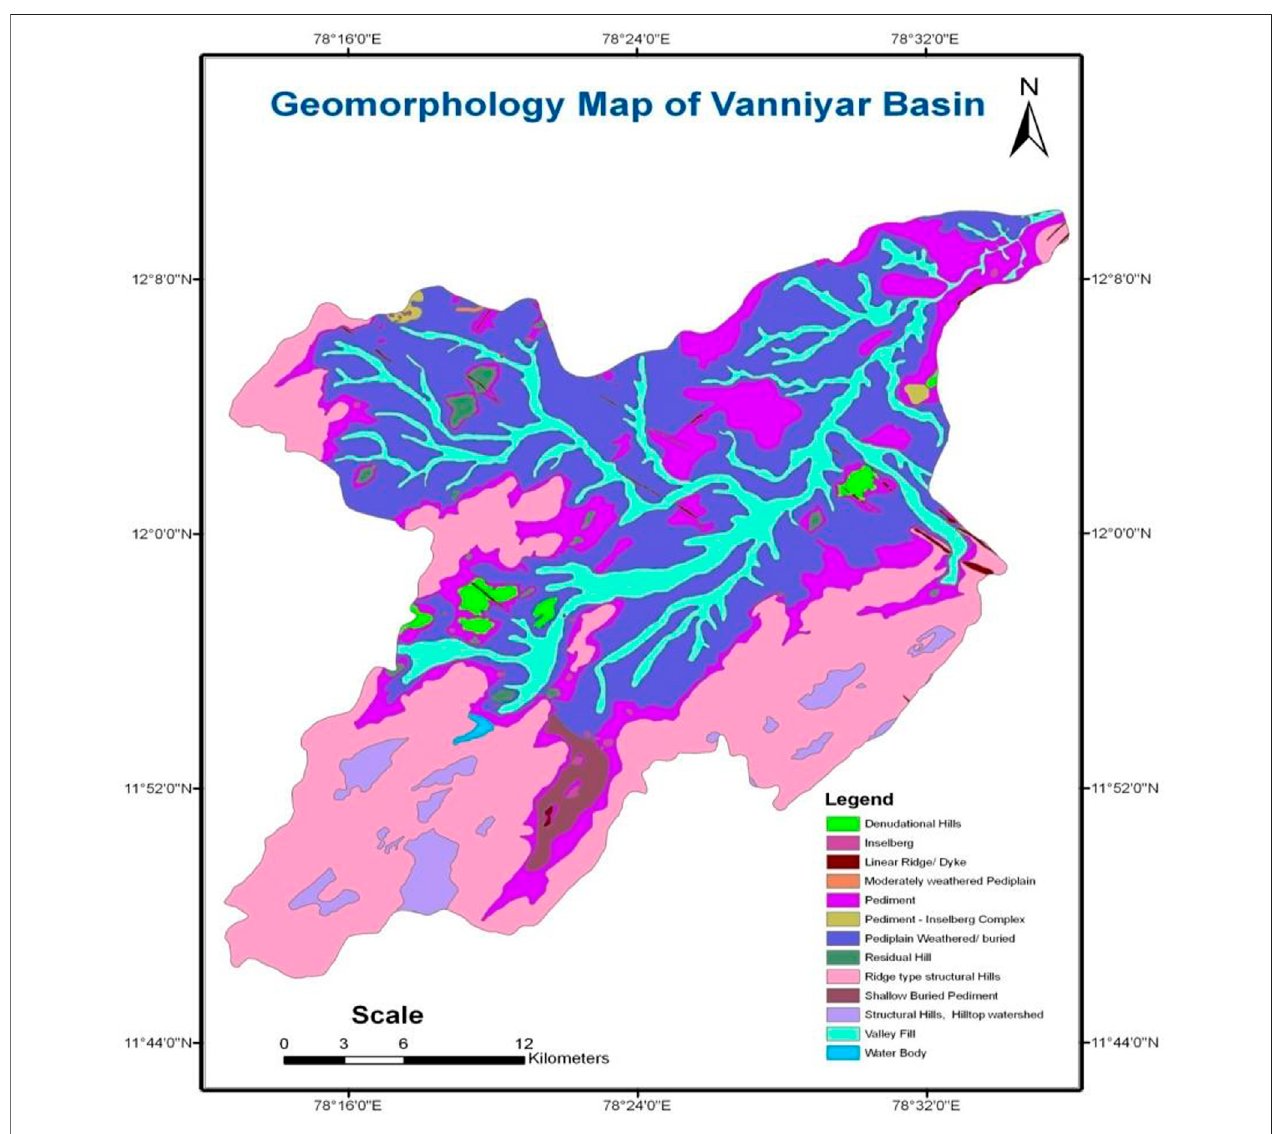
FIGURE 4 | Geomorphological characteristics of the Vanniyar basin, Dharmapuri district, Tamil Nadu, India.